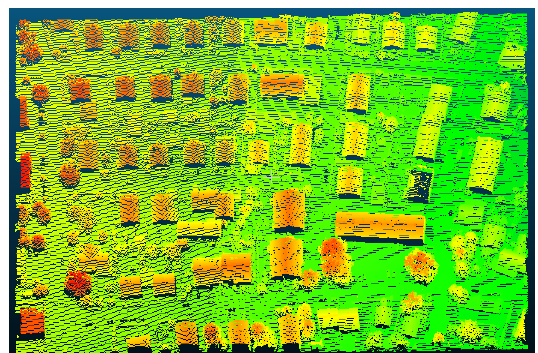
Figure 3.The test data of